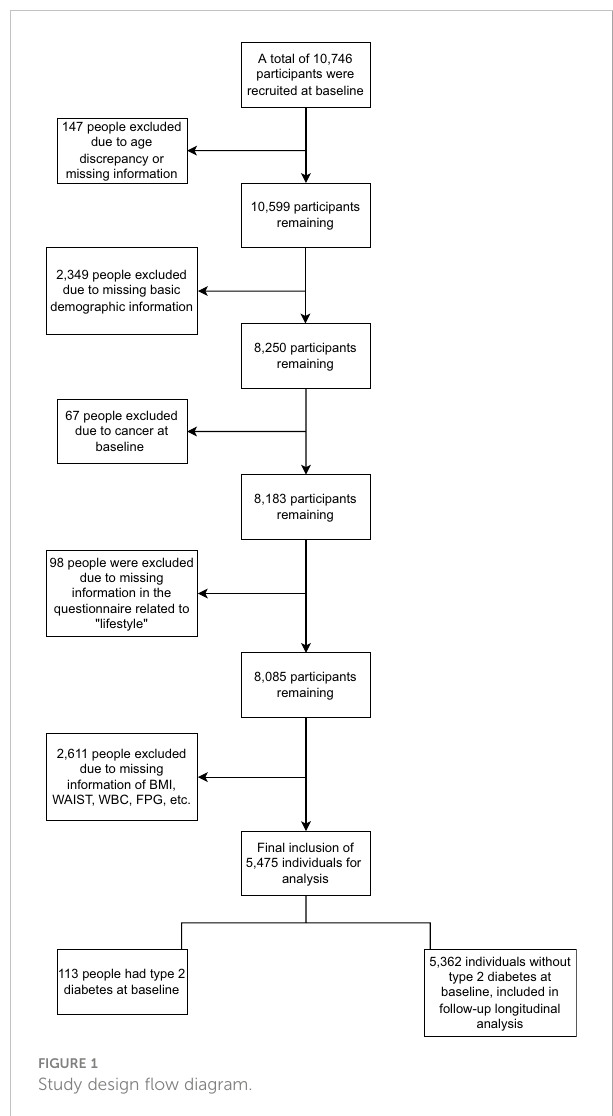
FIGURE 1 Study design fl ow